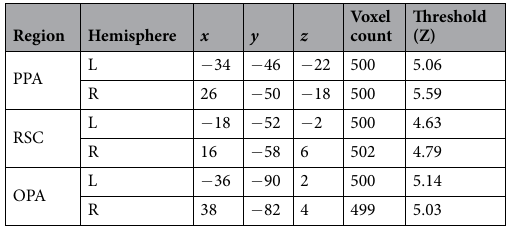
Table 1. Peak MNI mm co-ordinates, voxel counts, and thresholds of standard scene-selective clusters (PPA, RSC,